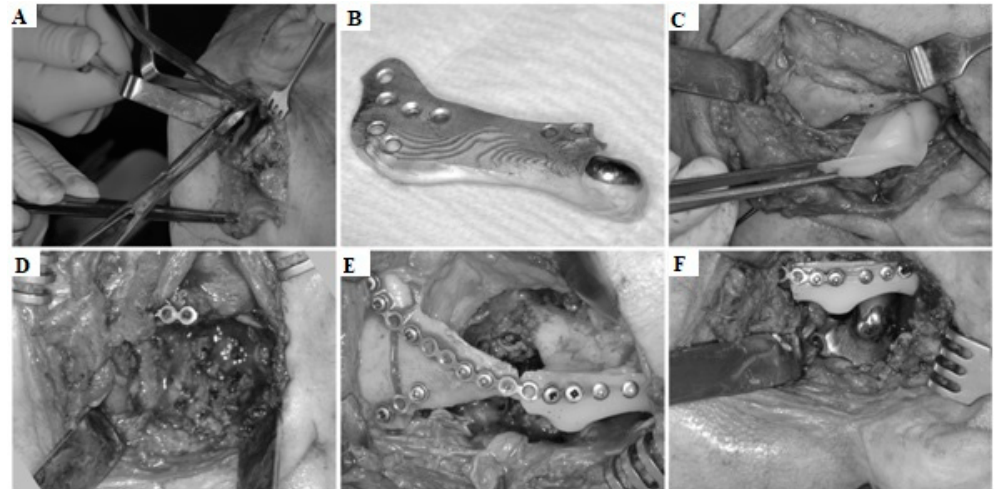
Figure 8. PET ‐ CT of the patient during follow ‐ up examination 5 years after the surgery. No increased 18 ‐ F ‐ FDG uptake in the region of the operation is present.